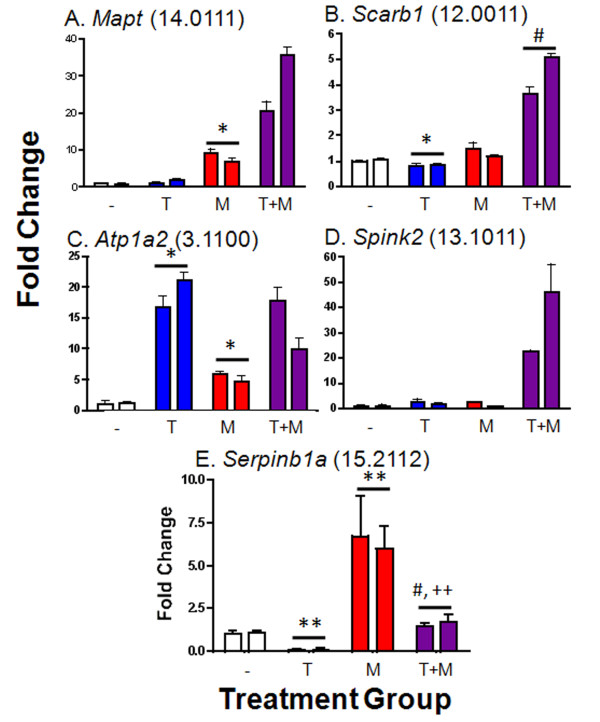
qPCR validation of microarray results for genes representative of five TFS groups. TM3-AR cells were treated with vehicle (DMSO, -), testosterone (T), MAA (M), or with T + MAA (T+M), as in Figure 1B. qPCR analysis was carried out for the five indicated genes; their TFS group assignments (Additional file 2, Table S2) are shown in parentheses. Two pools of TM3-AR cell RNA, each comprised on RNA isolated from 3 independent cell cultures, were assayed and are represented by the pair of bars in each treatment group. Data are mean ± SD values based on n = 3 replicates, with the first vehicle control pooled sample set to 1.0. Significantly different from control at p < 0.05 (*) or at p < 0.01 (**); significantly different from T at p < 0.05 (#); and significantly different from MAA at p < 0.01 (++). qPCR primers used for this analysis are shown in Additional file 1, Table S1.